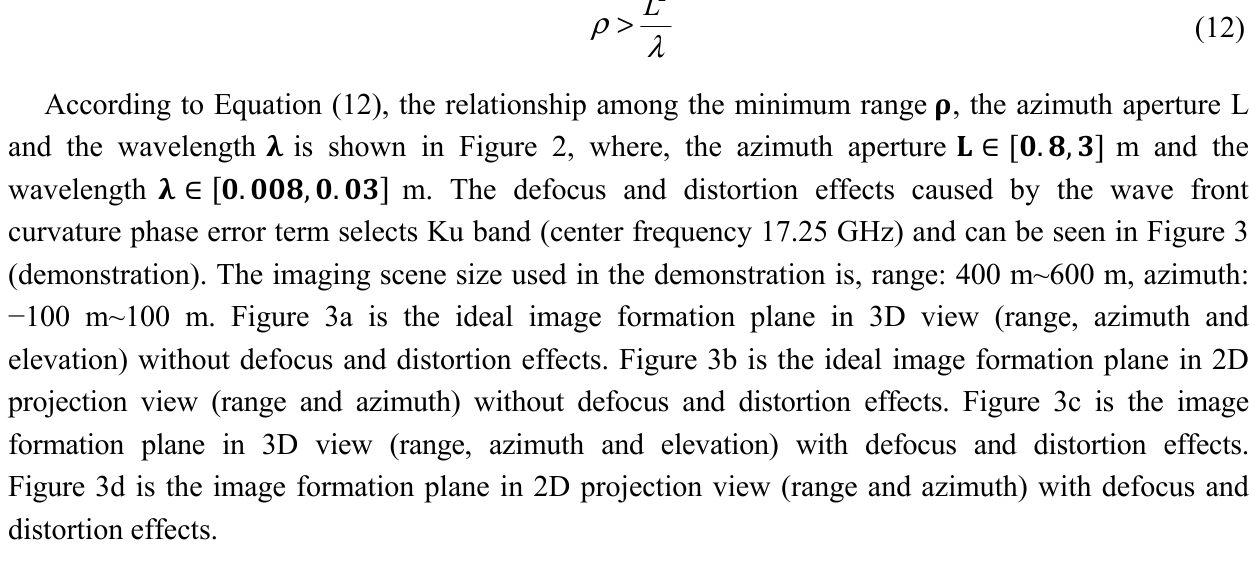
Figure 2. The minimum reference range for ignoring wave front curvature phase error term according to Equation